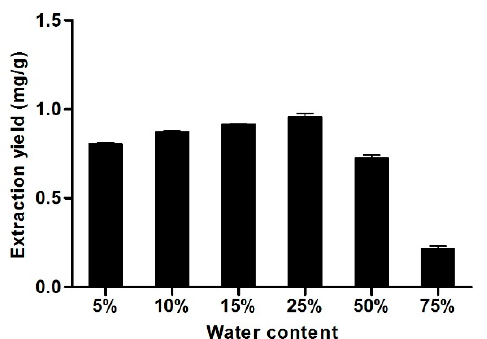
Figure 7. Rutaecarpine extraction yields of La-Buta DESs (1:0.5, molar ratio) diluted with different percentages of water. La-Buta DES aqueous solution (1:0.5, molar ratio) diluted with different percentages of water was used as a solvent to extract at a solid-liquid ratio of 1:50 with ultrasound at 35 °C and 500 W for 40 min. Data represent mean ± S.D. of triplicated experiments.